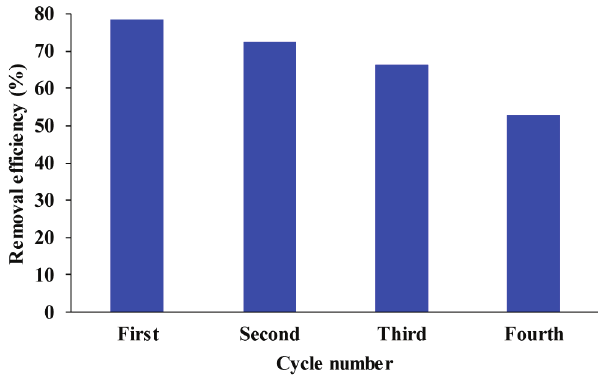
Fig. 9 – Reusability of Mn, Mo, la/Tio within four consecutive cycles